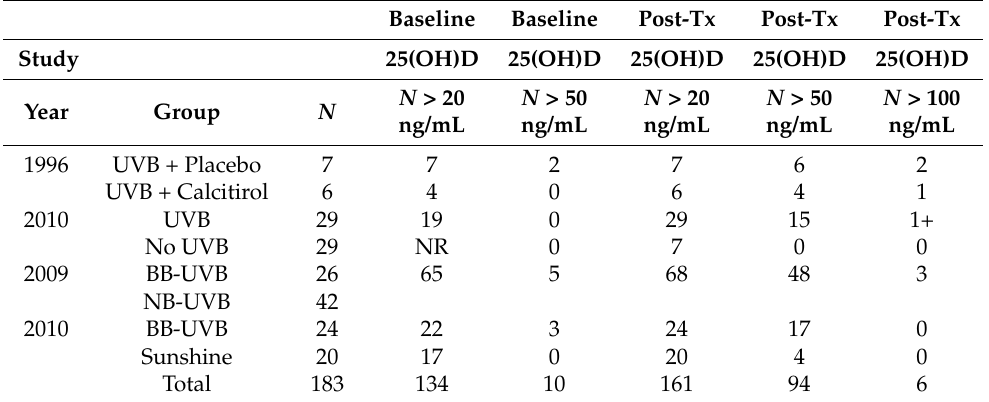
Table 5. Distribution of serum 25(OH)D concentrations greater than 20 ng/mL, 50 ng/mL and 100 ng/mL at baseline and post-treatment in each phototherapy clinical